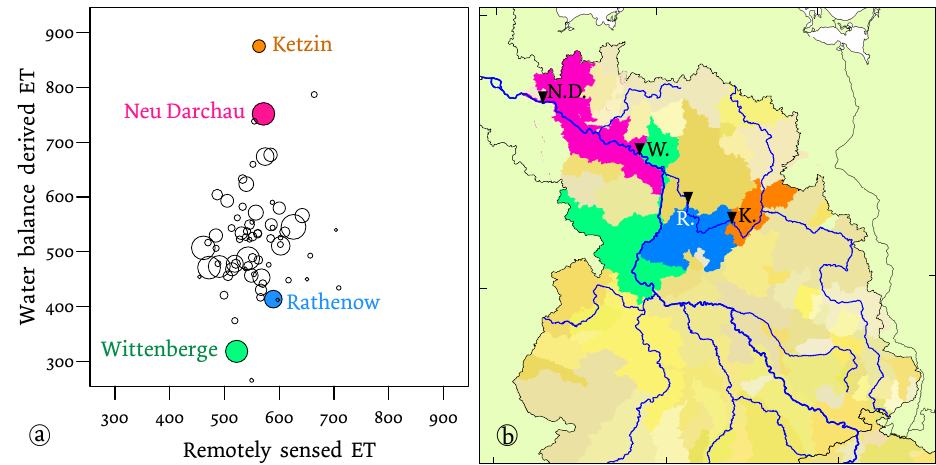
Fig. 15. Extreme differences between water balance derived ET from neighbouring sub-basins. The sub-basin areas in the dotty plot (a) are named according to their outlet gauges drawn in the map cut-out (b) as black